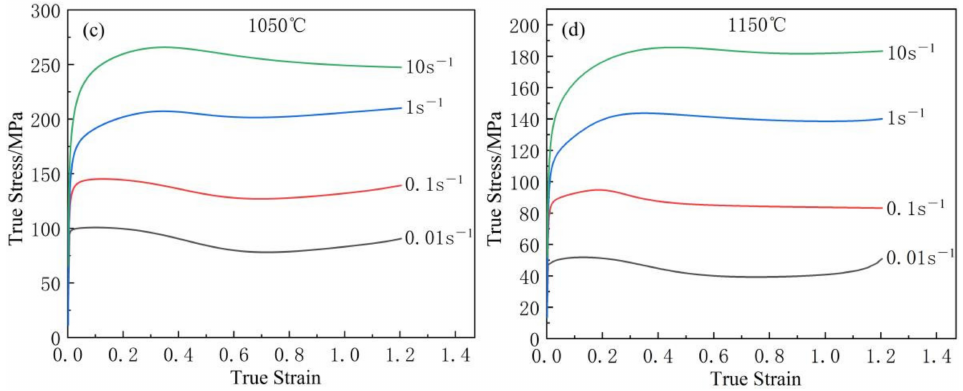
Figure 2. True stress–strain curves of M50 steel hot-compressed at different temperatures: ( a ) 900 ◦ C; ( b ) 1000 ◦ C; ( c ) 1050 ◦ C; and ( d ) 1150 ◦